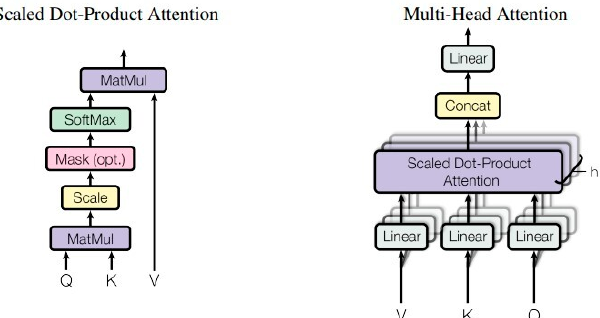
Figure 5. The details of self-attention and multi-head attention (The figure was adapted with permission from Ref. [25].